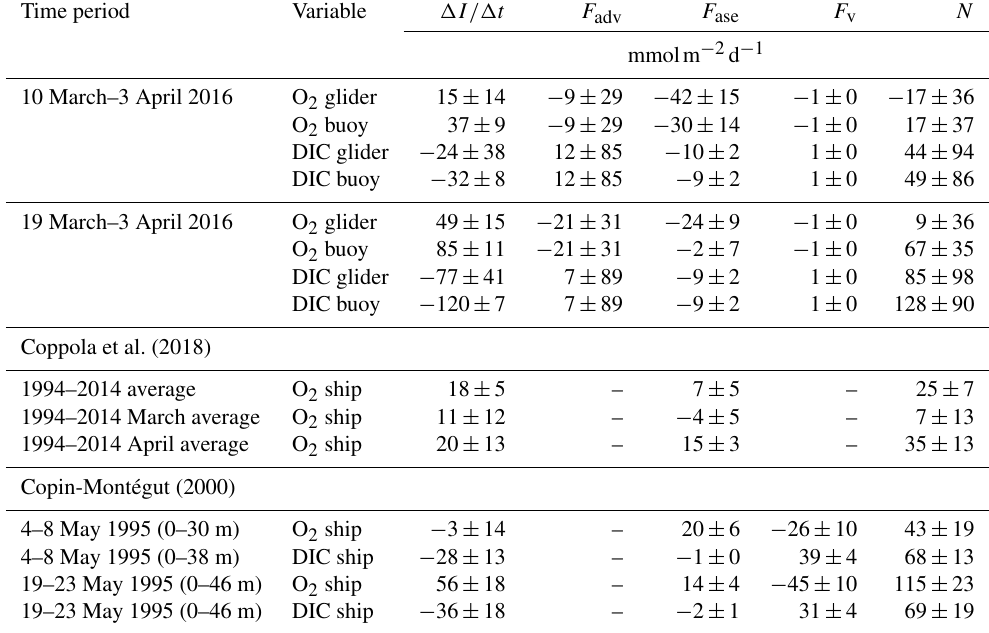
Table 2. Comparison of (cid:49)I/(cid:49)t , F adv , F ase , F v and N estimates using c( O 2 ) and c( DIC ) and the corresponding flux terms used in this study with others in the literature. The N estimates of Copin-Montégut (2000) are based on (cid:49)I/(cid:49)t , F ase and F v (calculated with a